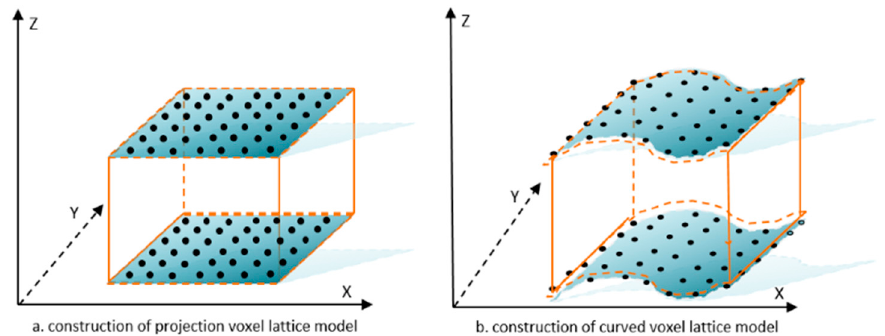
Figure 6. Spatial lattice model for stereoscopic space. ( a ) Construction of projection voxel lattice model; ( b ) Construction of curved voxel lattice model.